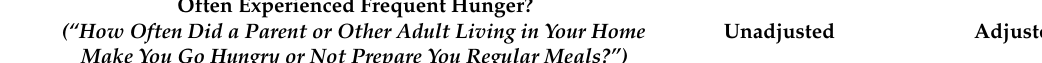
Table 1. Sociodemographic characteristics of individuals who often experienced hunger during childhood in the United